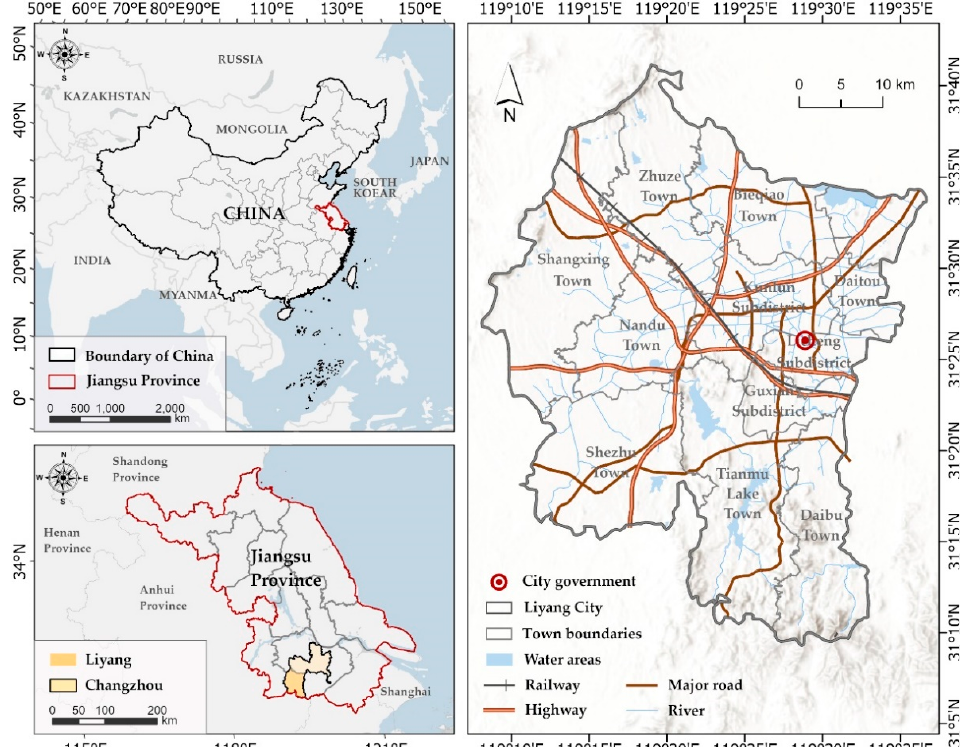
Figure 1. Location of Liyang City.